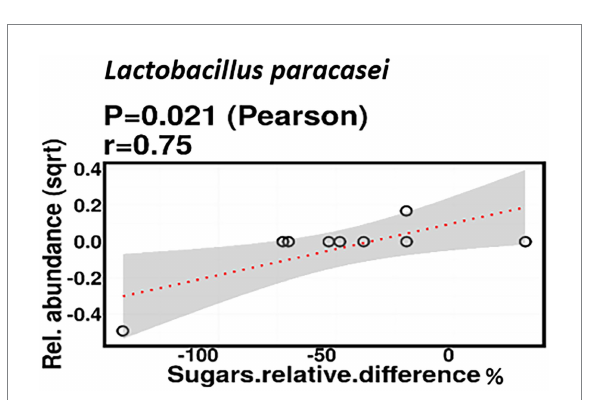
FIGURE 9 Change in maternal sugar intake % was positively correlated with the relative abundance of Lactobacillus paracasei